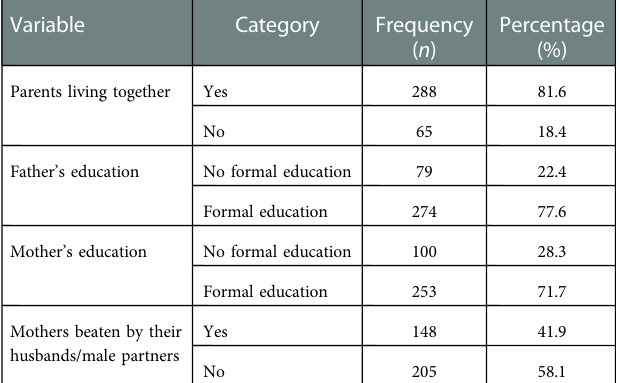
TABLE 2 Family history of respondents among female university students, southwest Ethiopia, 2021 ( n =353). Variable